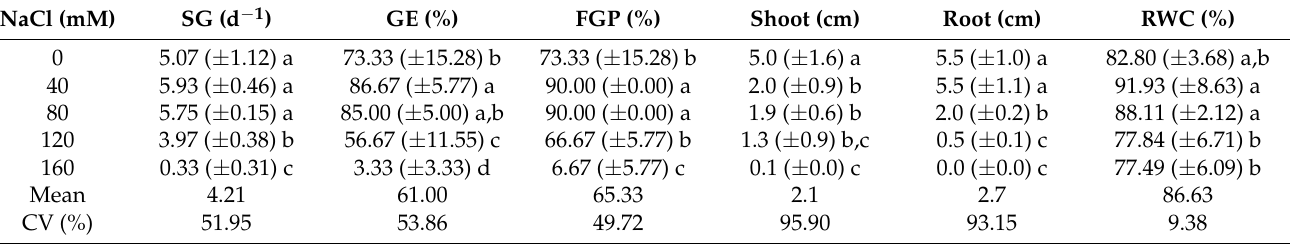
Figure 1. MR219 seedlings after 10 days of NaCl treatment. Table 1. Changes in seed germination and growth performance parameters of MR219 treated with different salt concentrations.